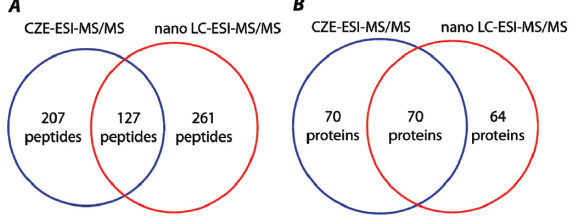
Figure 8 Venn diagram illustrating the overlap of peptides and proteins identified by both CZE-ESI-MS/MS and UPLC-ESI-MS/MS: (A) peptides, (B) proteins. Reprinted with permission from reference